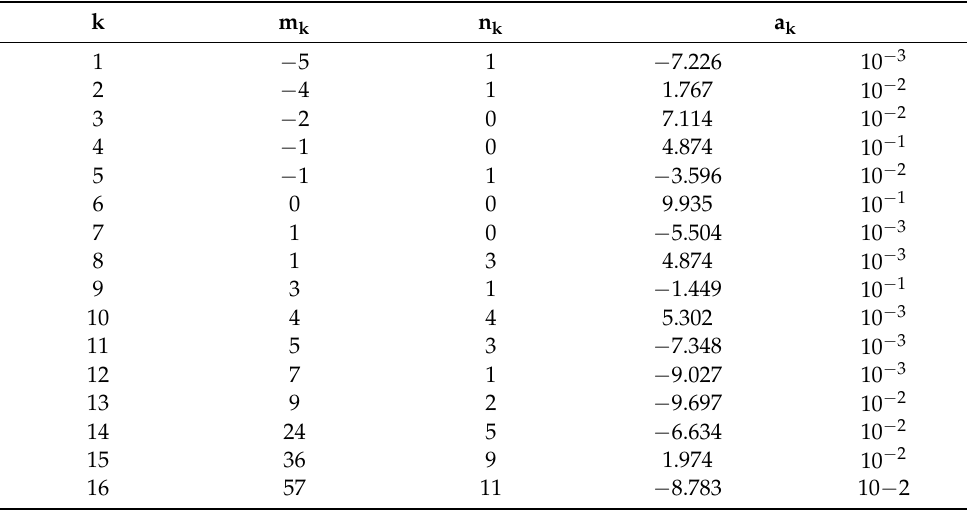
Table A1. Coefficients of the water superheated enthalpy